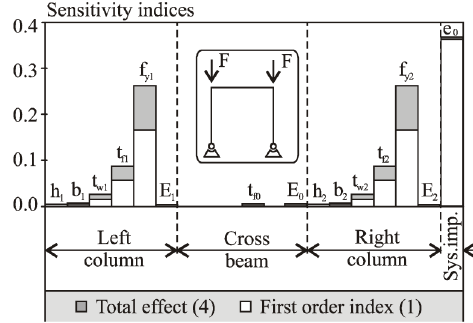
Fig. 9. Total sensitivity analysis – Frame 2, h = 3